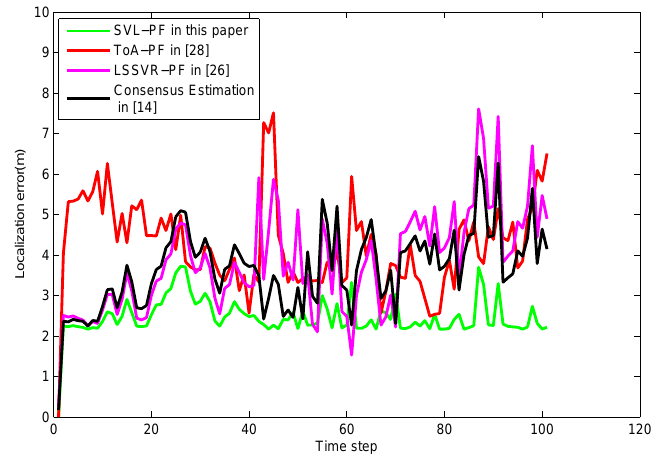
Figure 5. The localization errors of the proposed algorithm and the compared algorithms in the universal noise